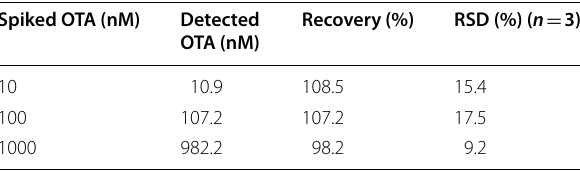
*Δ Signal represents the difference of measured signal at the corresponding OTA concentration from the standard curve